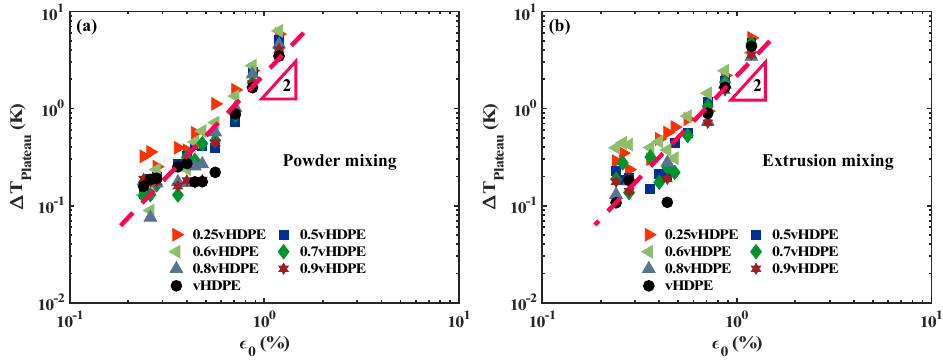
Figure 12. Surface temperature rise of the blends with different vHDPE content during fatigue tests at ε 0 = 0.24–1.19%, R = 0.3 and f = 5 Hz for samples produced via: ( a ) powder mixing and ( b ) extrusion mixing.